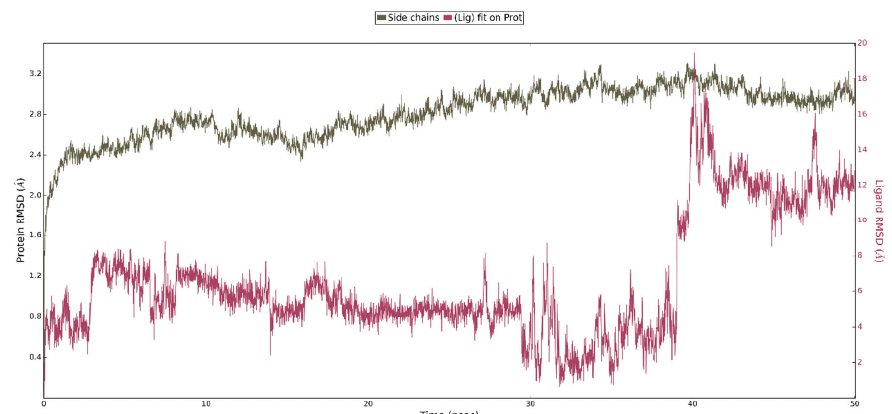
Figure 11. The above plot shows the RMSD evolution of a protein backbone (green) and ligand 4 aligned with the protein backbone of the reference position - magenta calculated for all frames in aligned with the protein backbone of the reference position ‐ magenta calculated for all frames in the simulation. the simulation.